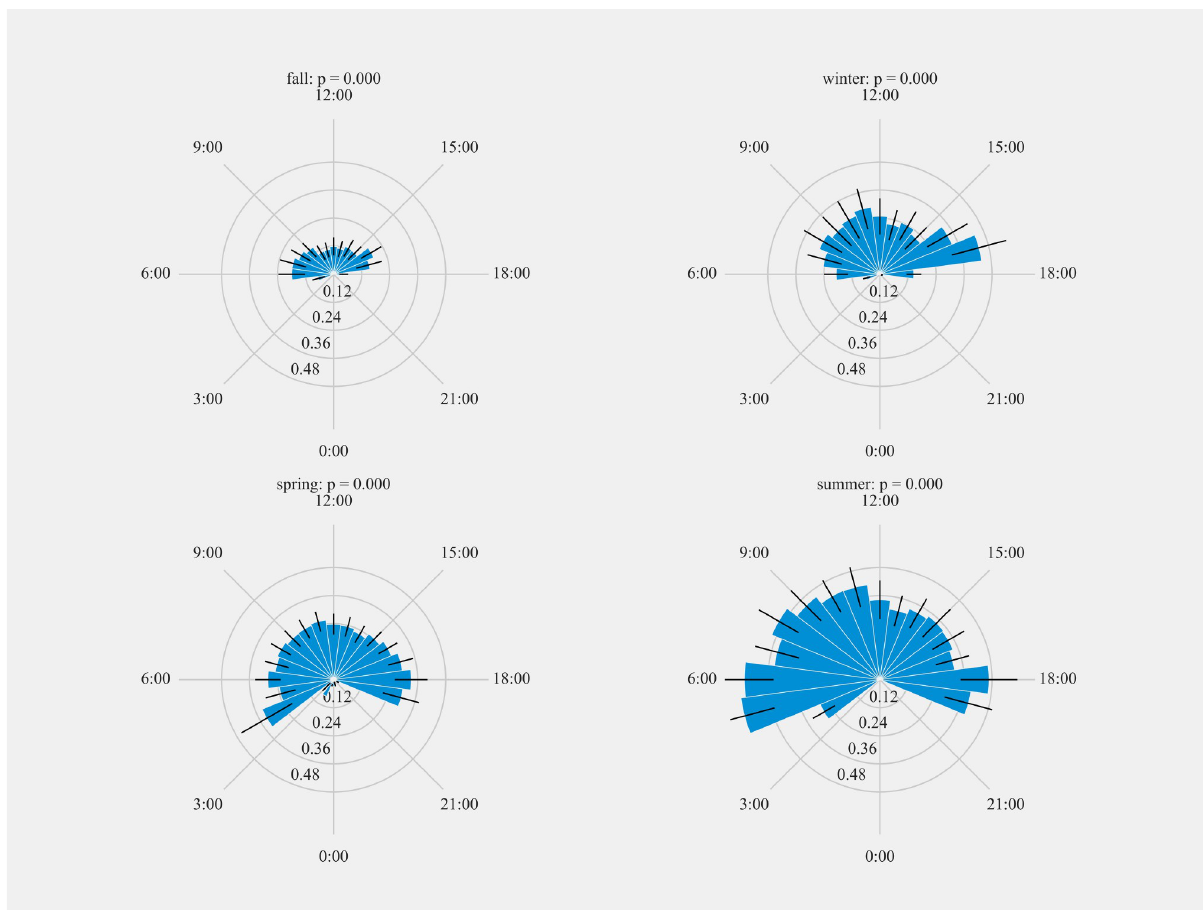
Fig 8. Diel plots of mean hourly Anna’s Hummingbird visits to the feeding stations at three sites at northern and southern California from September 2016 to March 2018. The bar denotes the mean hourly visits by hummingbirds and black lines show the standard error. All distributions were statistically non-uniform (probability values reported by